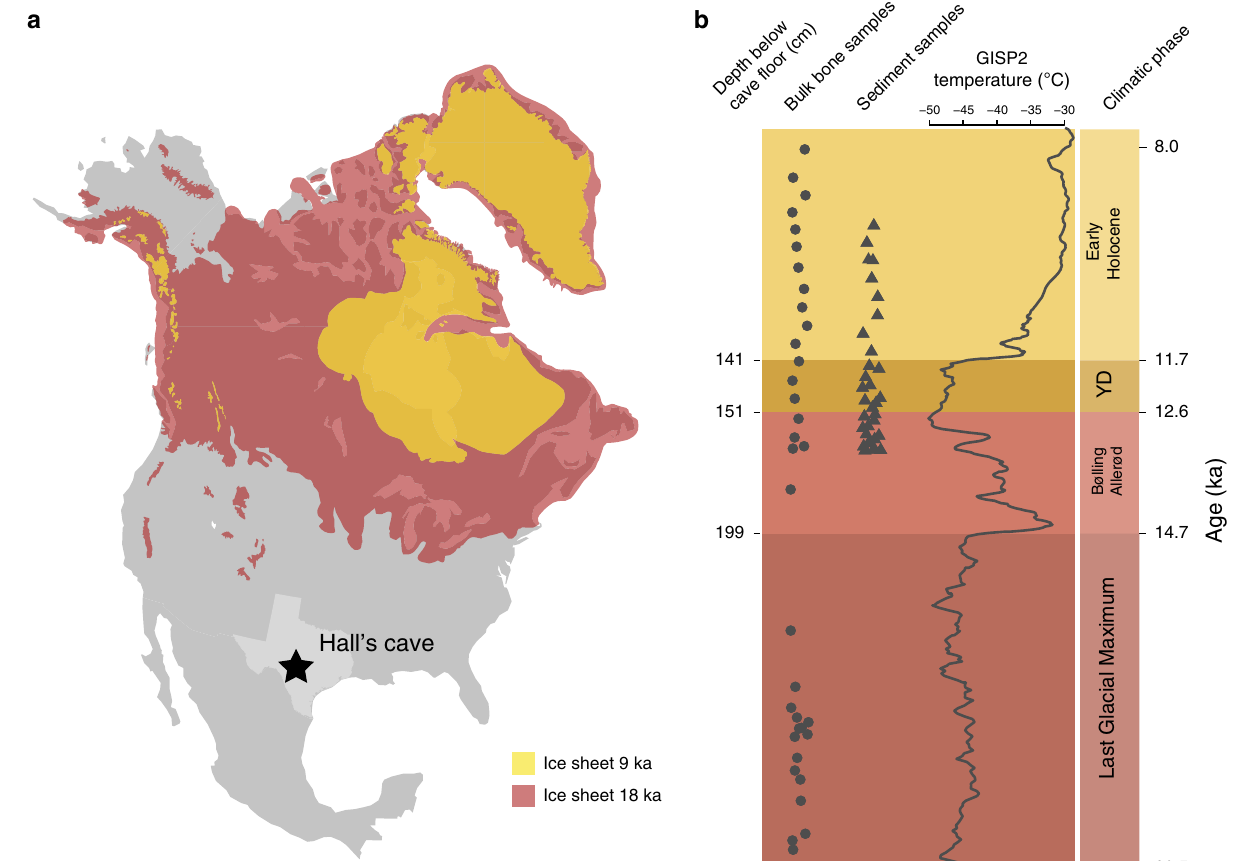
Fig. 1 Sampling location and stratigraphy. a Location of Hall ’ s Cave in North America, with the continental ice sheets and mountain glaciers shown at 18,000 and 9000 cal BP 65 . b Left panel, sample ages at Hall ’ s Cave for bulk-bone samples (circles) and sediment samples (triangles) based on calibrated ages (ka cal BP). Middle panel, ambient temperature over Greenland based on δ 18 O values, dated by counting annual accumulation layers (years before Y2k; Greenland Ice Sheet Project 2 — GISP2 14 ). Right panel, time period